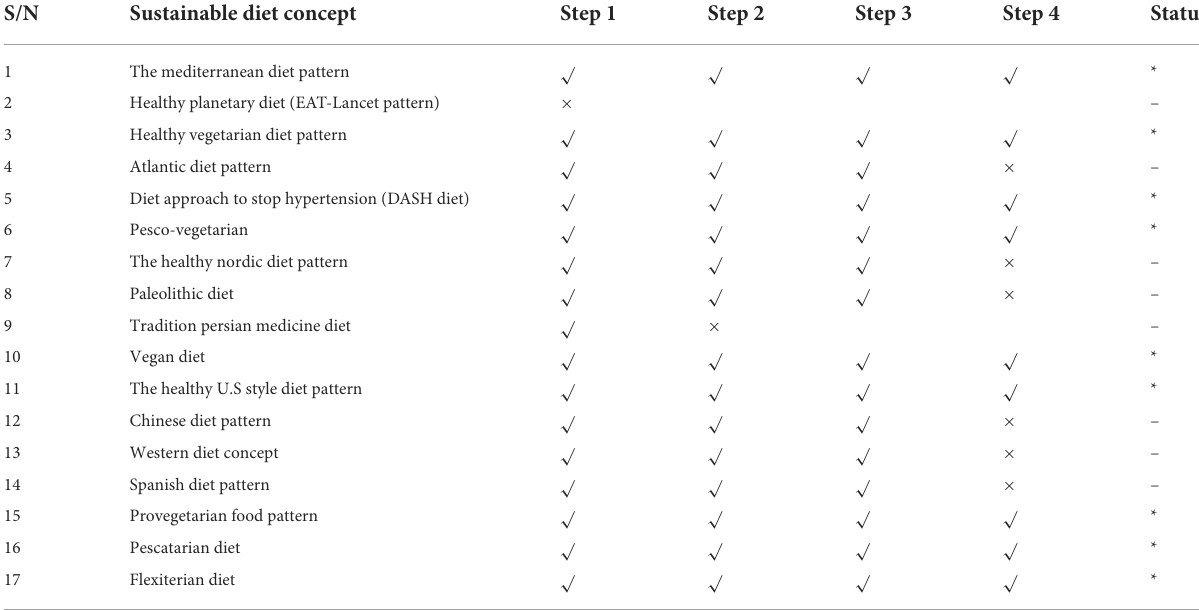
TABLE 4 Selected sustainable diet concepts after the four-step inclusion/exclusion criteria. S/N Sustainable diet